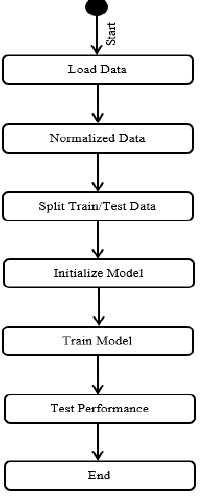
Figure 5. Steps involved in the proposed